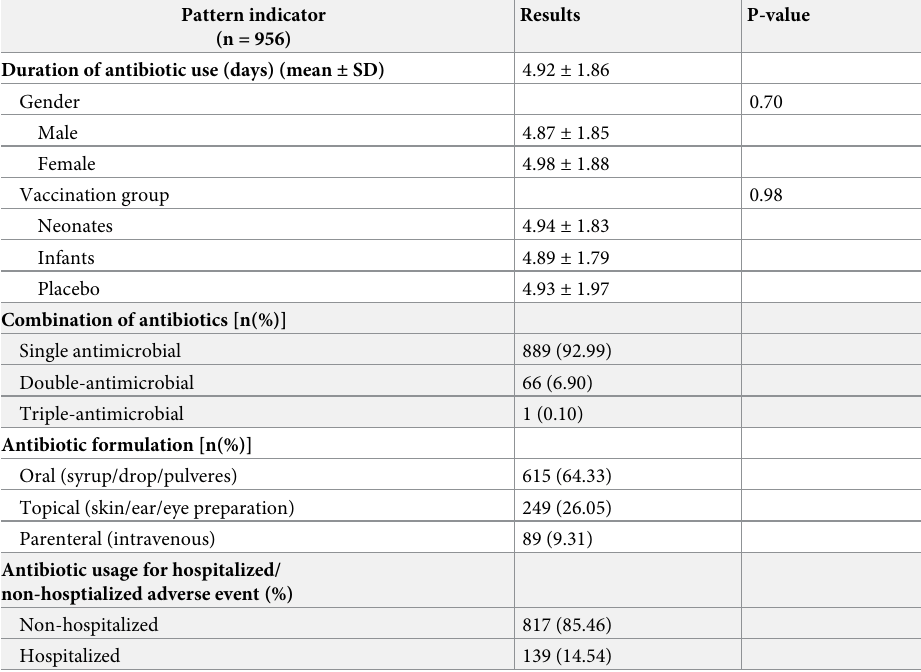
Table 2. The pattern of antibiotic use as